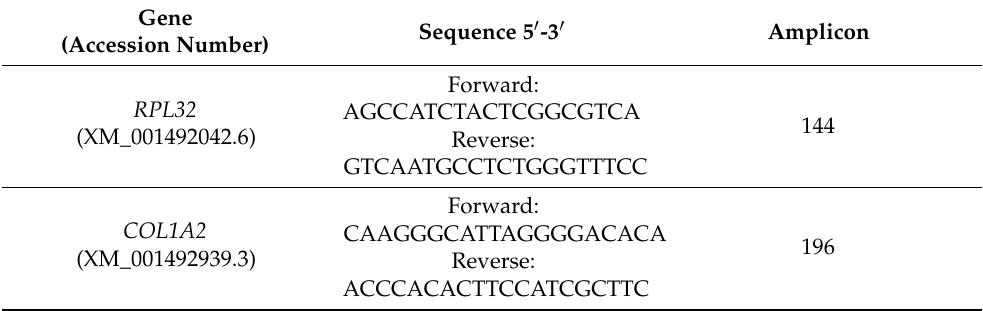
Table 2. Sequences of primers utilized in quantitative real-time polymerase chain reaction